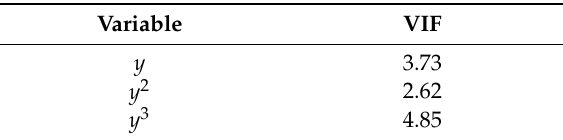
Table 5. Variance inflation factors (VIFs) (Multicollinearity test).